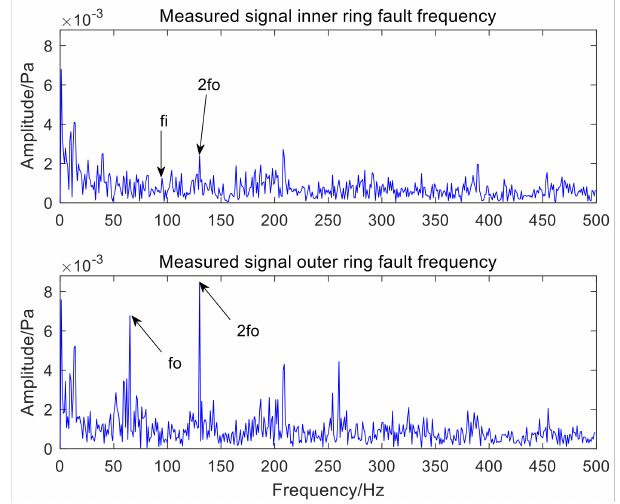
Figure 19. The envelope spectrum of an acoustic signal using the EEMD-MVO-MCKD.